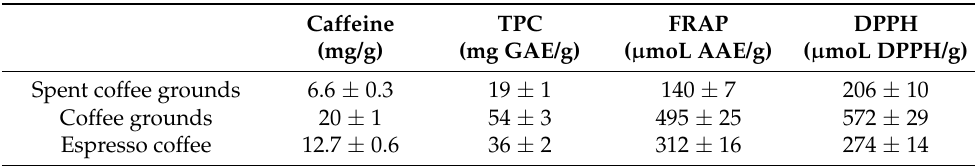
Table 5. Content of extracts from SCGs, coffee grounds, and espresso coffee in caffeine and TPC and FRAP and DPPH